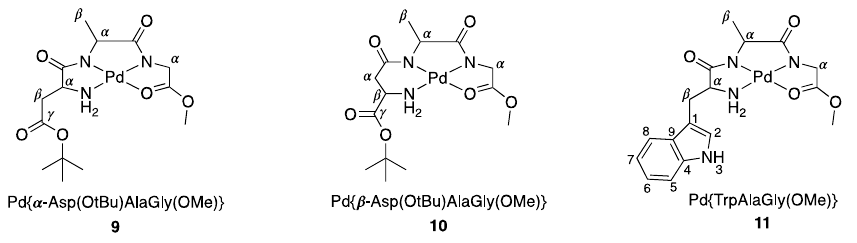
Figure 3. Tetradentate tripeptide Pd(II) complexes with coordinated ester